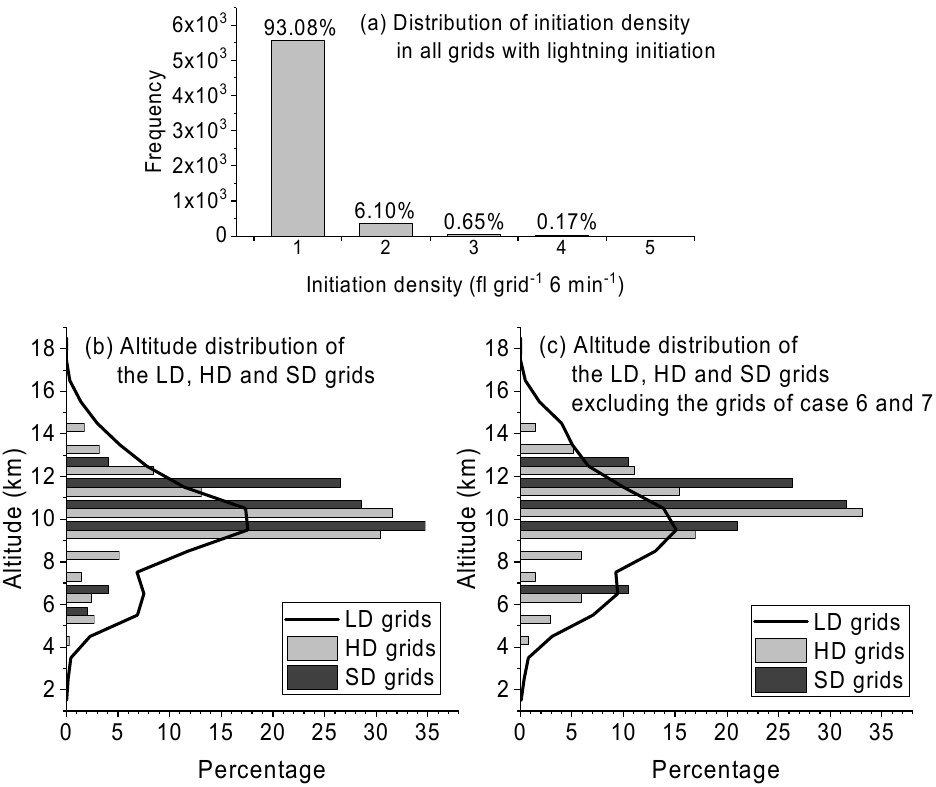
Figure 2. ( a ) Distribution of the convective grids with different initiation densities and altitude distributions of the LD, HD and SD grids in ( b ) all cases and ( c ) the cases excluding Case 6 and 7.